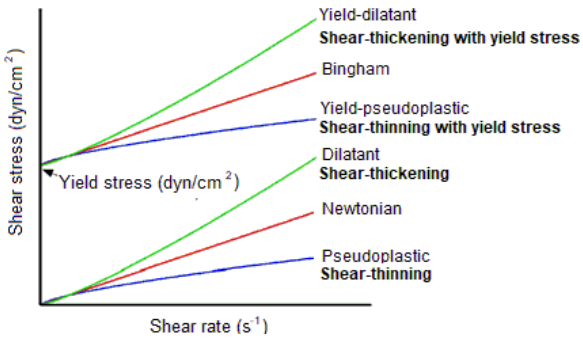
Figure 1: Rheological behaviors of Newtonian and non-Newtonian